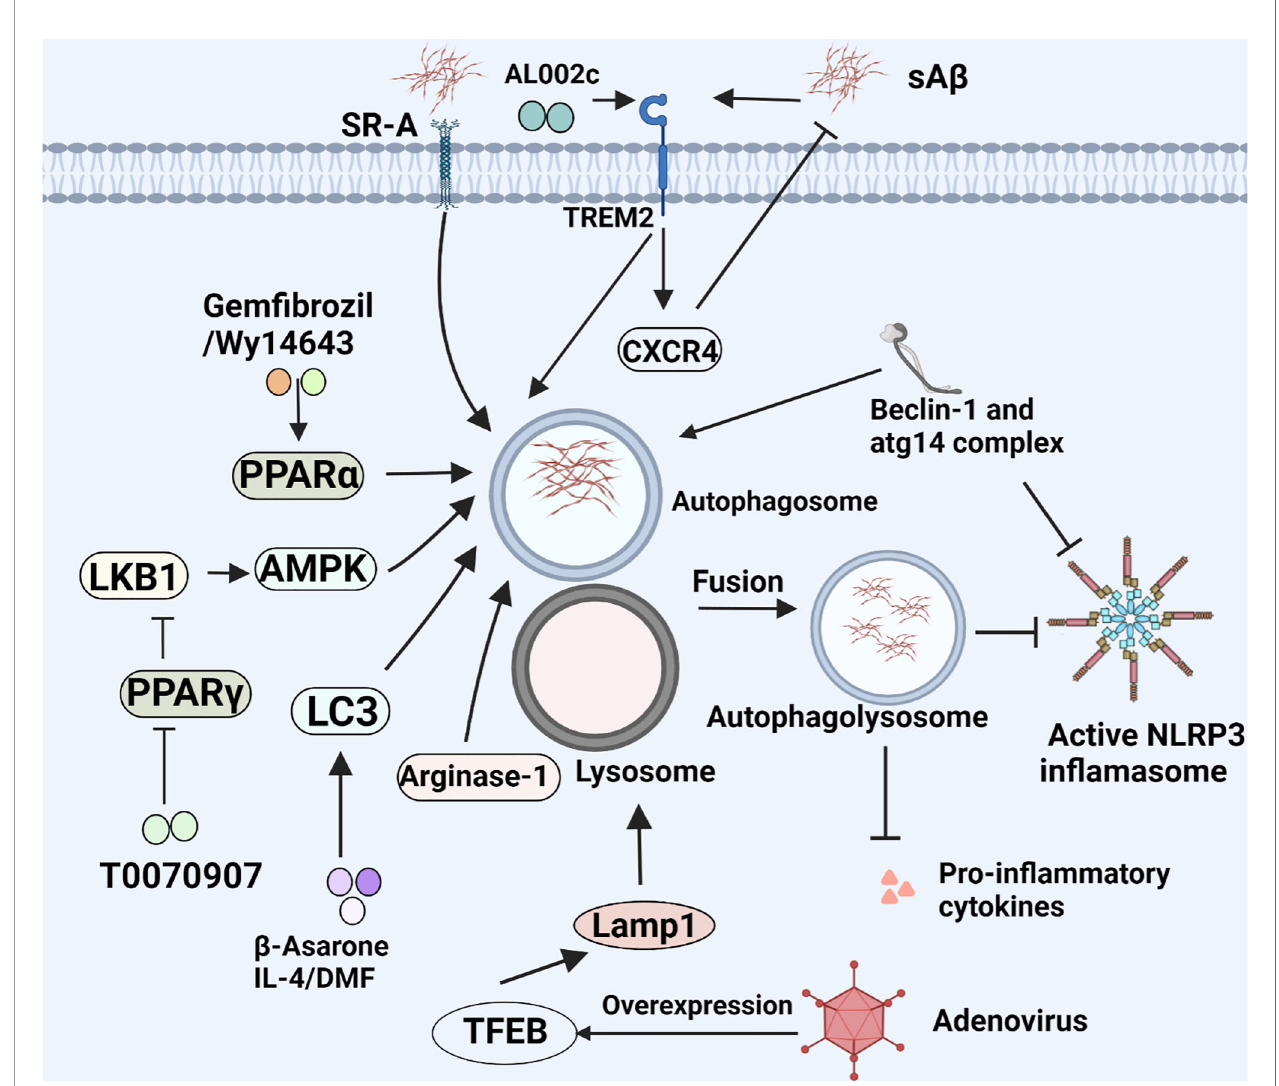
FIGURE 4 | Microglial phagocytosis and autophagy in AD. Microglia eliminate A b load through phagocytosis and autophagy. This fi gure displays the regulatory mechanism of this